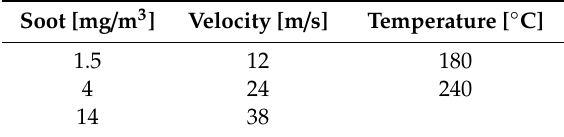
Table 7. Steady-state levels for the tested sensors (Sensors